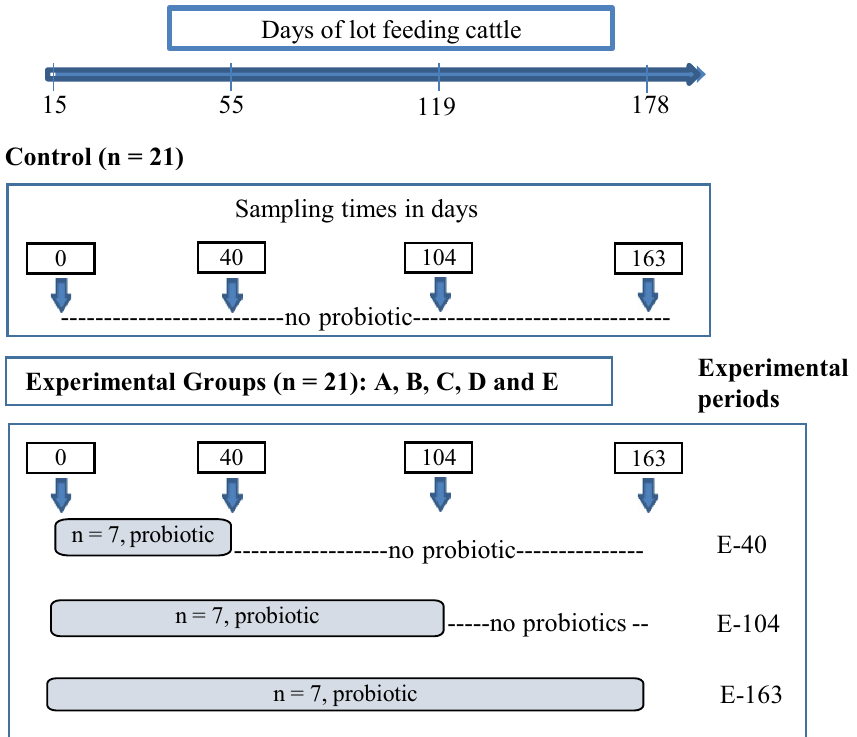
Figure 1. Experimental design: probiotic experimental groups: A: Lactobacillus acidophilus CRL 2074; B: Limosilactobacillus fermentum CRL 2085; C: Limosilactobacillus mucosae CRL 2069; D: CRL 2085 + CRL 2069; E: CRL 2074 + CRL 2085 + CRL 2069; Control group (n = 21) included in a separate pen. Sampling time in days: 0 (T0), 40 (T1), 104 (T2) and 163 (T3). Experimetal periods of probiotics administration E-40, E-104 and E163. Sampling scheme: animals (n = 7) received probiotics up to 40 days and then removed (to separate pen) experimental period E-40; animals (n = 7) received probiotics up to 104 days and then removed, E-104 and, animals (n = 7) administered with probiotics for 163 days E-163. This scheme was replicated for the A, B, C, D and E experimental